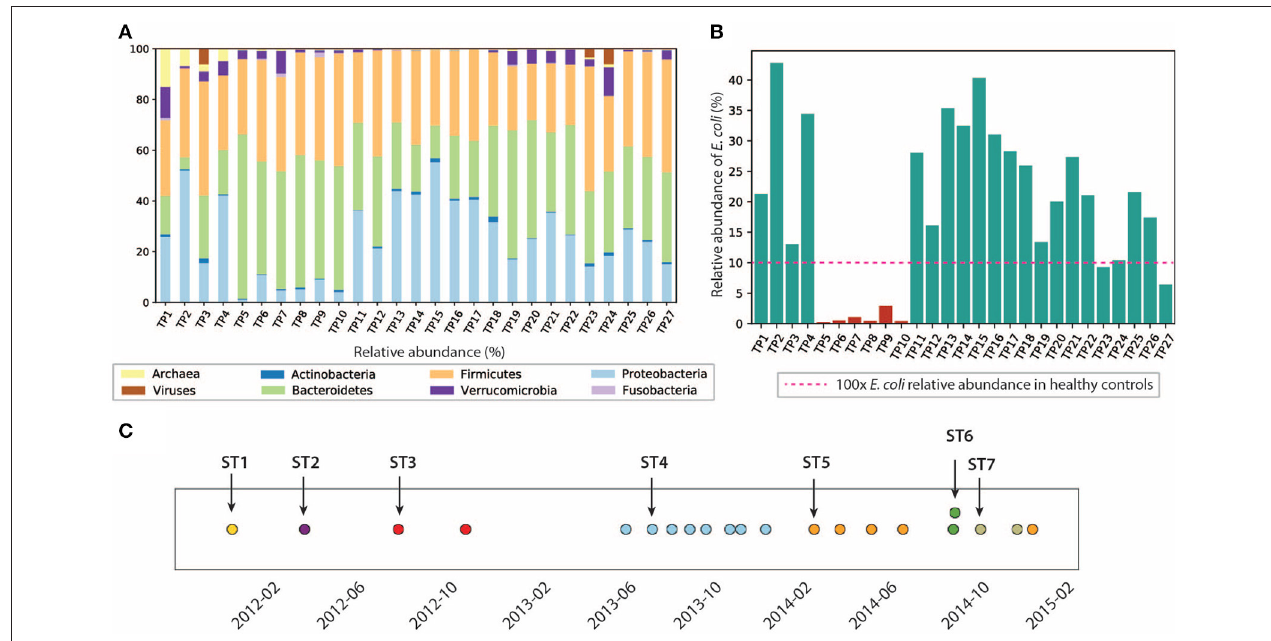
FIGURE 2 | Composition of the gut microbiome and the E. coli community is dynamic. (A) Relative abundance of microbes at phyla level. (B) Relative abundance of E. coli in this patient. E. coli relative abundance is < 0.1% in the healthy cohort. (C) Dominant strains of the E. coli community identified in 21/27 samples. Colors represent different dominant strains. Arrows highlight the samples we selected for further analysis on dominant strains.